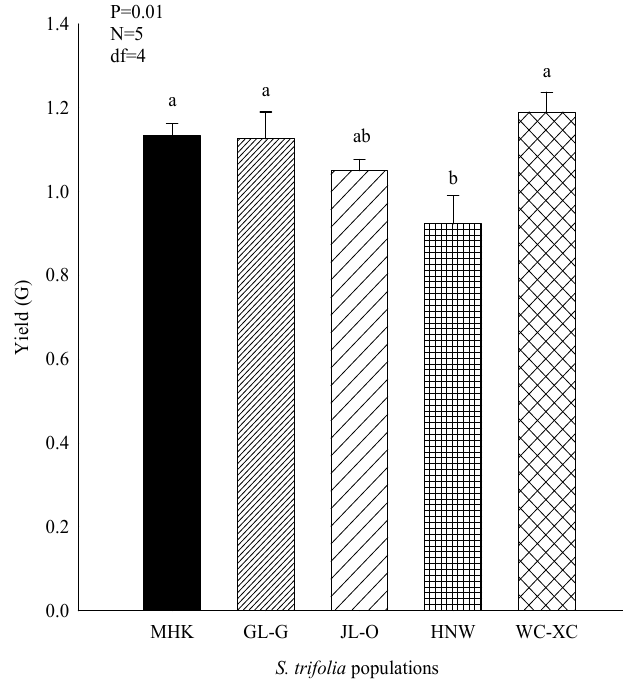
Figure 1. Extract yield (g) obtained from different populations of S. trifolia . Values are represented as the mean ± standard error. The same letters on bars indicated that the values are not significantly different according to Tukey’s HSD at the p > 0.05 level. N= number of replications; df = degree of freedom.